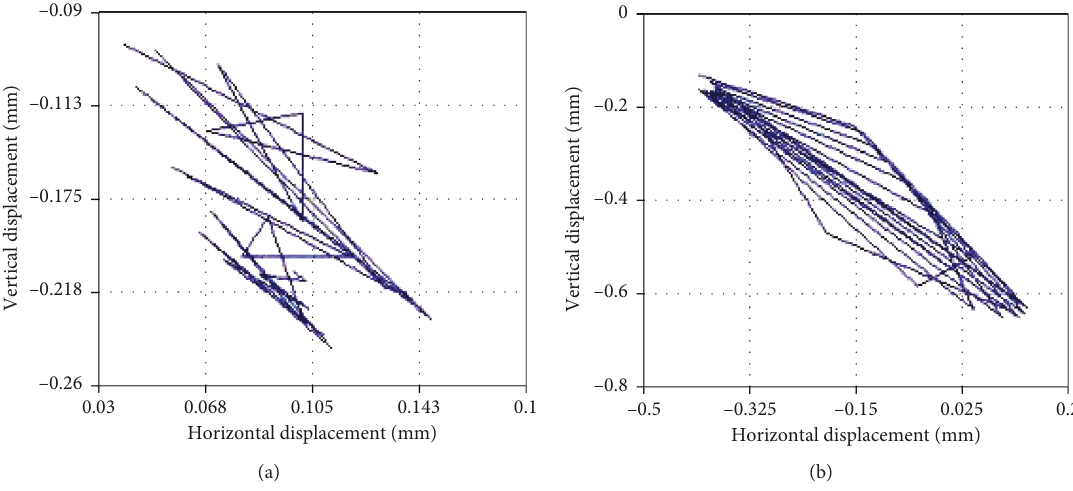
Figure 8: Axis trajectory of cylinder II in 0.1second. (a) Under no-load condition. (b) Under threshing condition.